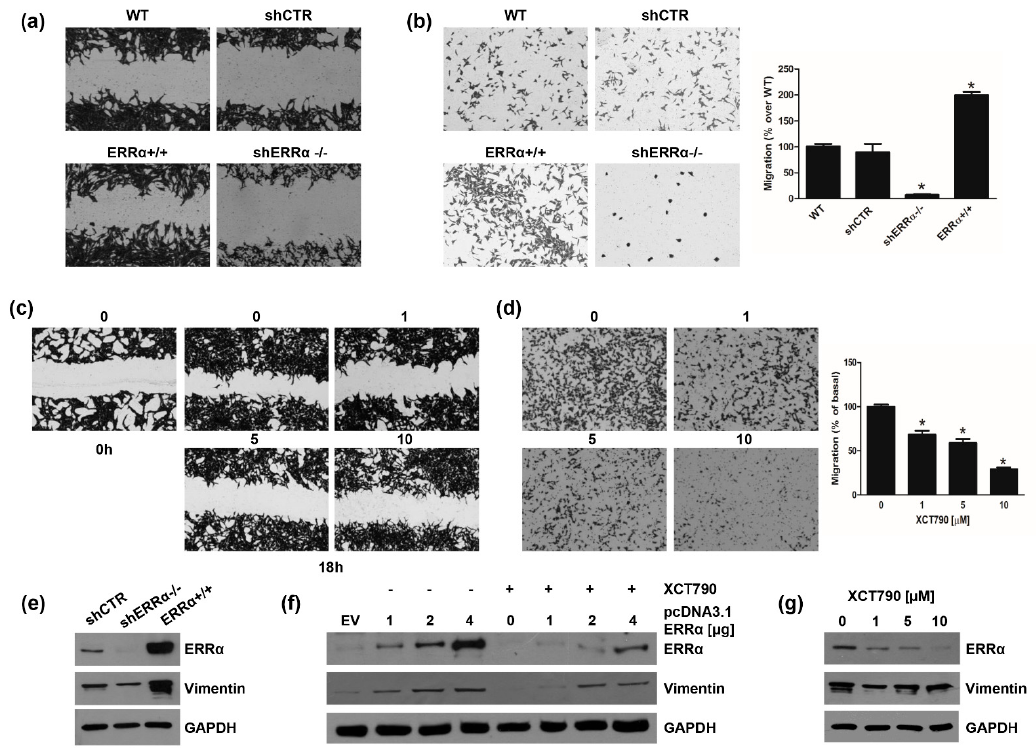
Figure 6. ERR α modulates H295R cell motility and Vimentin expression. ( a , b ) H295R (WT), H295R clones, knock in (ERR α +/+) or knock out (shERR α − / − ) for ERR α gene, and H295R cell stably transfected with control plasmid (shCTR) were used in Wound Healing ( a ) and Boyden Chamber ( b ) assays as reported in “Materials and Methods”. Images are from a representative experiment. ( c , d ) H295R cells were treated with vehicle (0) or XCT790 (1, 5, 10 µ M) for 18 h and Wound Healing ( c ) and Boyden Chamber ( d ) assays were performed as reported in “Materials and Methods”. Images are from a representative experiment. ( c ) The wounds were observed under an inverted microscope immediately (0 h) and 18 h after the scratch (100 × magnification). ( b , d ) Migrated cells were pho- tographed under an inverted microscope and counted (see Material and Methods), 20 × magnification. Graphs represent the mean ± SD of three independent experiments. The number of untreated cells (0) was set as 100% (* p < 0.05 vs. 0). ( e ) Total proteins from H295R clones (shCTR, shERR α − / − , ERR α +/+) were analyzed by western Blotting (WB) using antibodies against ERR α and Vimentin. GAPDH was used as a loading control. Blots are representative of three independent experiments with similar results. ( f ) H295R were transfected for 48 h with pcDNA3.1 non containing (EV) or containing ERR α coding sequence (pcDNA3.1-ERR α ). After transfection cells were left untreated ( − ) or treated (+) for 24 h with XCT790 (10 µ M). Total proteins were analyzed by WB using antibodies against ERR α and Vimentin. GAPDH was used as a loading control. ( g ) Cells were untreated (0) or treated with XCT790 (1, 5, 10 µ M) for 24 h. Total proteins were analyzed by WB using antibodies against ERR α and Vimentin. GAPDH was used as a loading control. Original image of western blot can be found at File